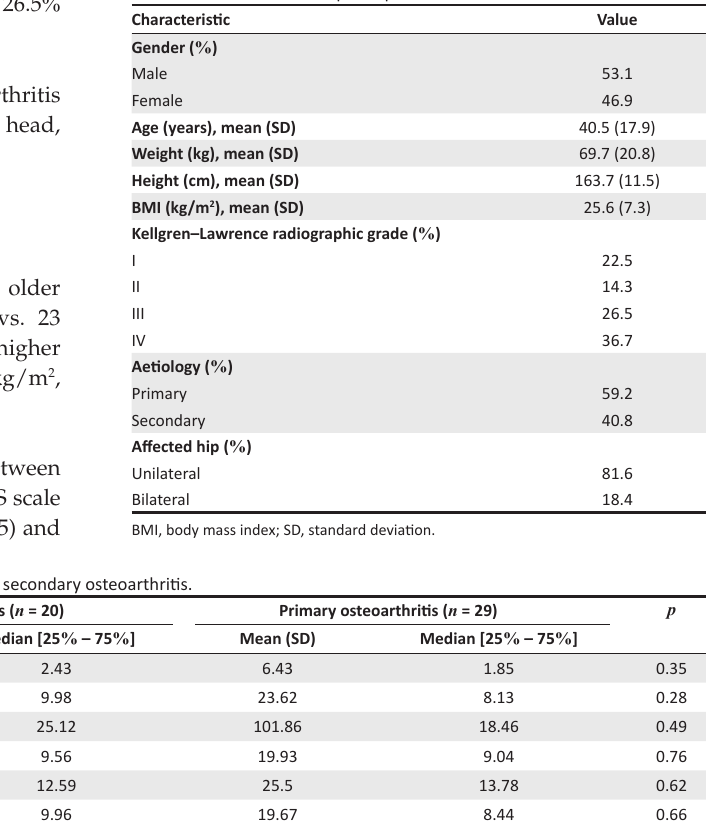
TABLE 1: Characteristics of participants.